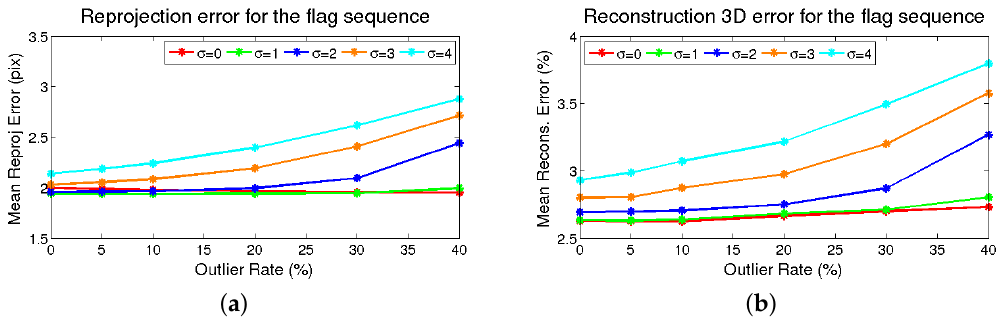
Figure 5. Flag sequence results for noise and outliers’ degradation on tracking. ( a ) The column depicts the error variation with the o outlier points’ percentage of the reprojection error. Each trace corresponds to a different noise σ level. ( b ) The column represents the same for the 3D reconstruction